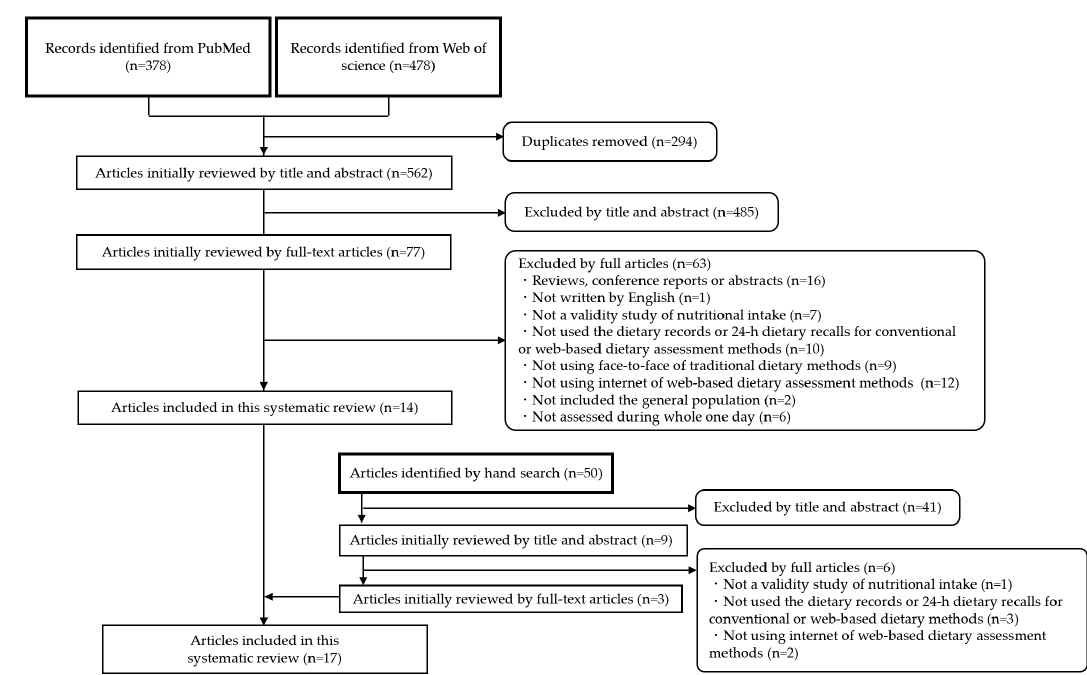
Figure 1. Flow diagram of the article selection process.